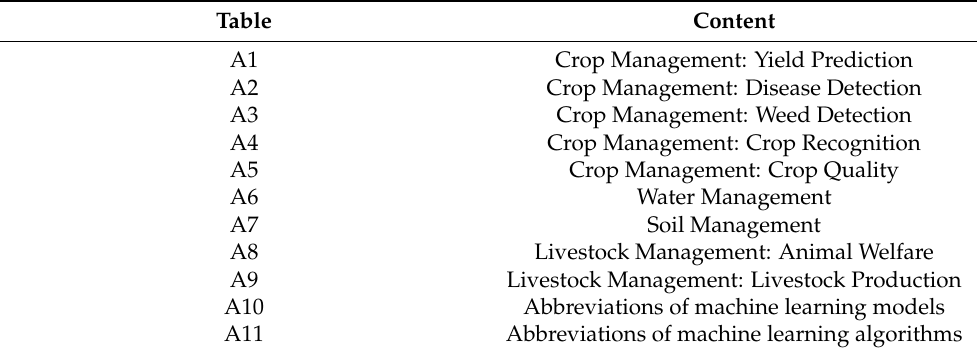
Table 2. List of the tables appearing in the Appendix A related to: (a) the categories and sub-categories of the machine learning applications in agriculture (Tables A1–A9) and (b) the abbreviations of machine learning models and algorithms (Tables A10 and A11,